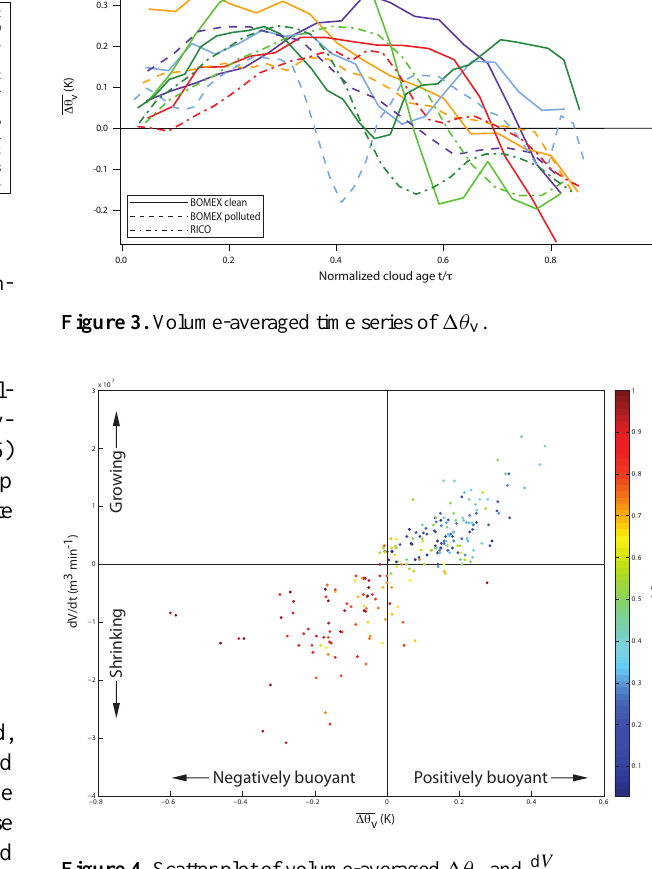
likely that there exists an accurate clock for this time period. corresponds to the final 3 to 5 min of cloud lifetime.